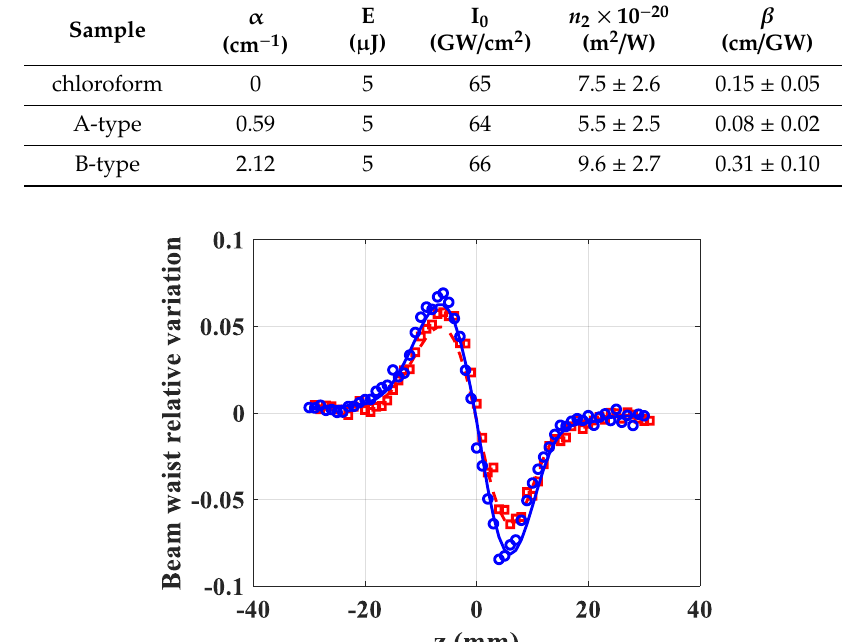
Table 2. Results of the nonlinear optical measurement of ZnO particles in chloroform at 355 nm Sample